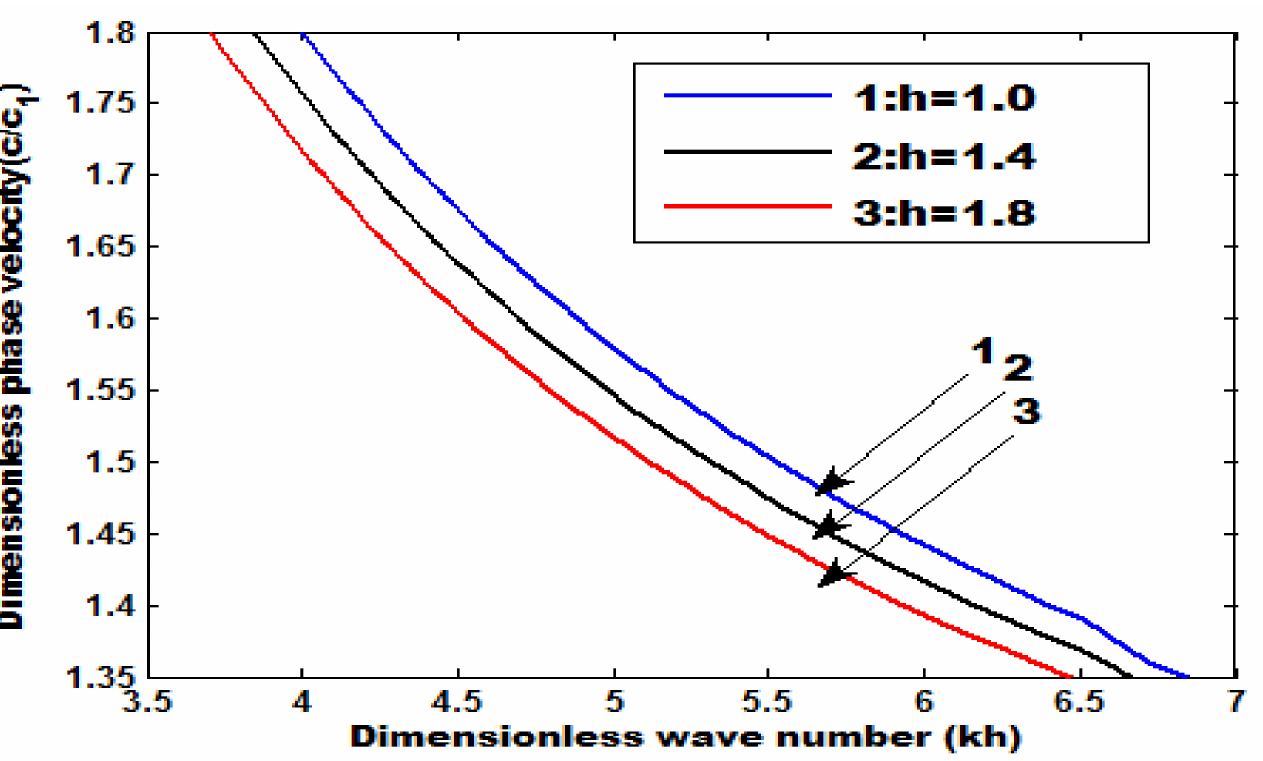
Figure 5. The phase velocity with wave number when m = 0.08, a 1 = 0.1, p = 0.01, a 2 = 0.2, α = 0.2, β = 0.1.